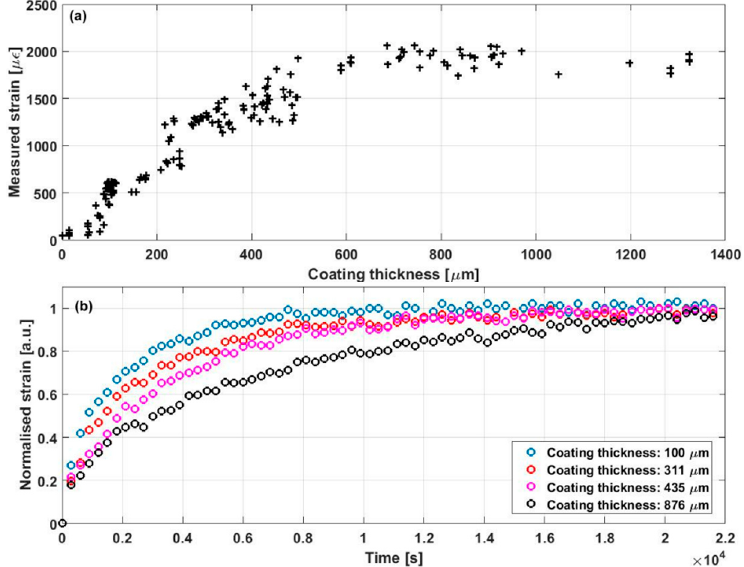
Figure 14. (a) Strain change along the test fibre as a function of coating thickness, when the relative humidity was raised from 20% to 70%. (b) Normalised strain response of polyimide-coated fibres with different thickness when the relative humidity changed from 15% to 30%. Modified with permission from Reference [80].